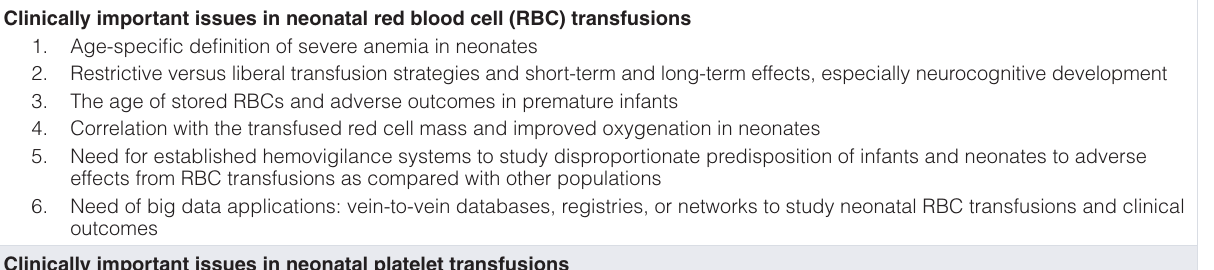
Table 1. Summary of clinically important issues in neonatal transfusion. Clinically important issues in neonatal red blood cell (RBC)